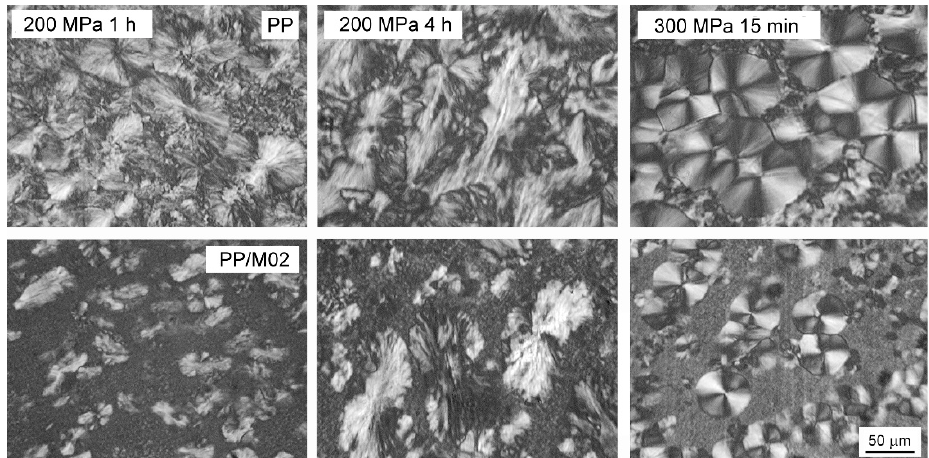
Figure 8. PLM micrographs of thin sections of neat PP and PP/M02 crystallized according to proto- col II under 200 and 300 MPa.